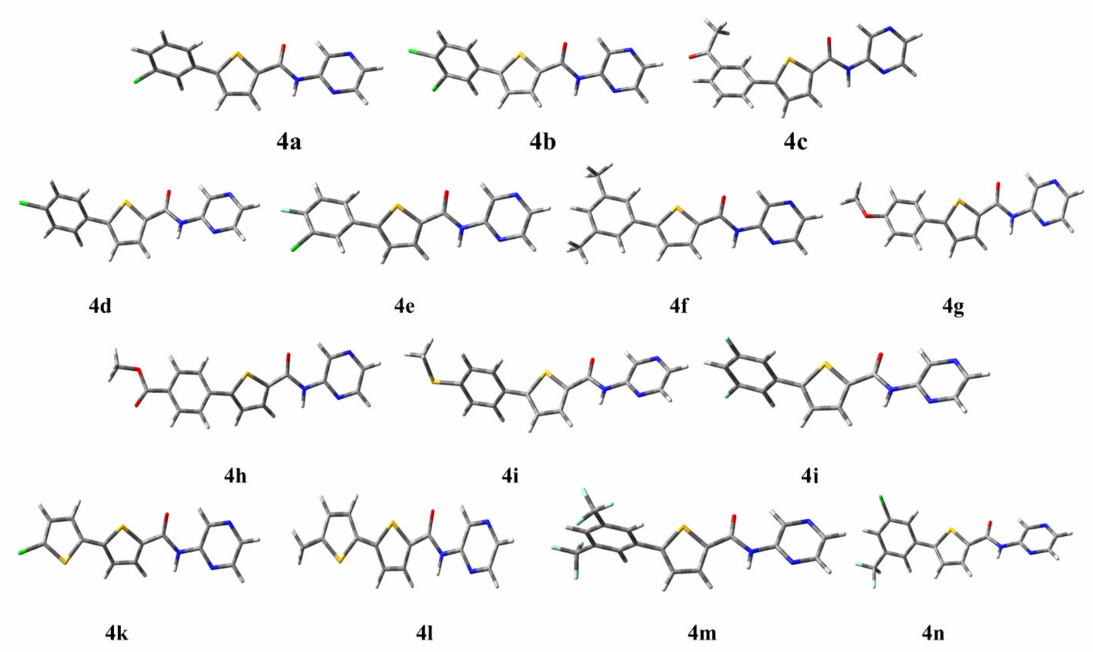
Figure 3. Optimized structures of all the final derivatives ( 4a – 4n ). In the 3D models, the yellow color indicates S, the red color represents oxygen, the grey color indicates C, the green color is for Cl, the light blue color shows F and the white color symbolizes